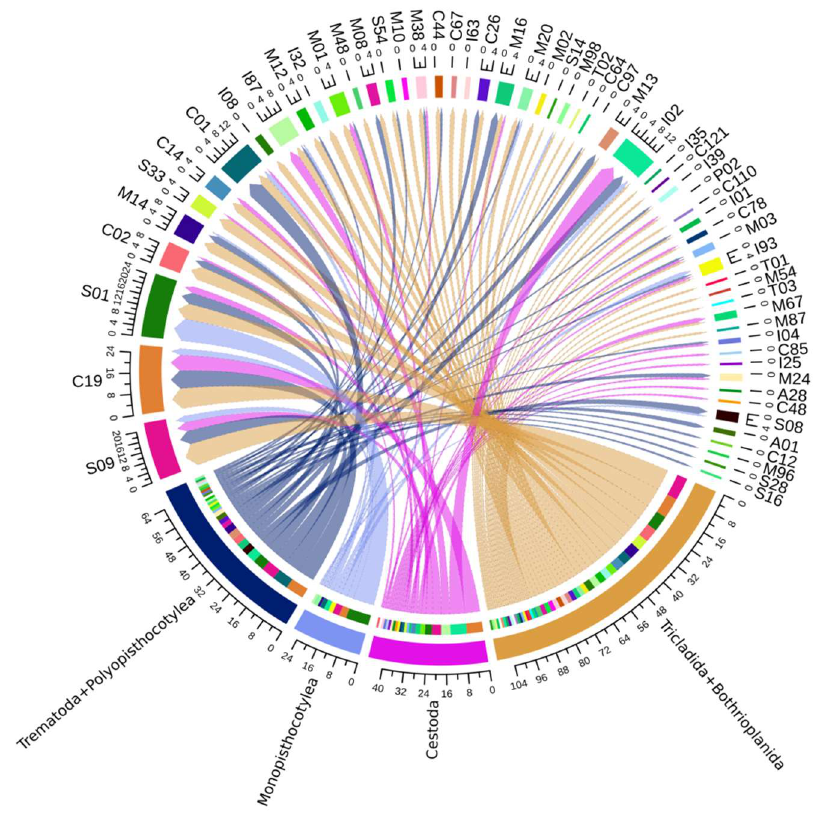
Figure 5. Circus chart representing the OGs of peptidase and inhibitor families that most contribute to the formation of groups in the HCPC and network analyses.